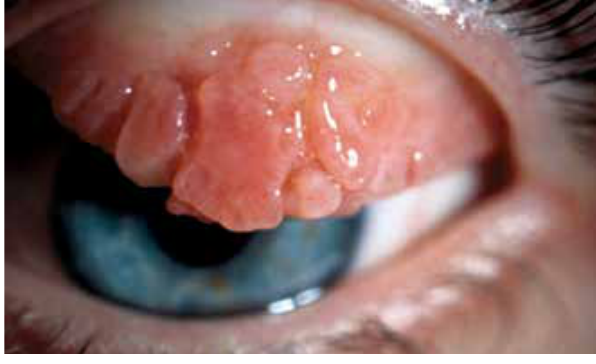
Figure 3: Vernal